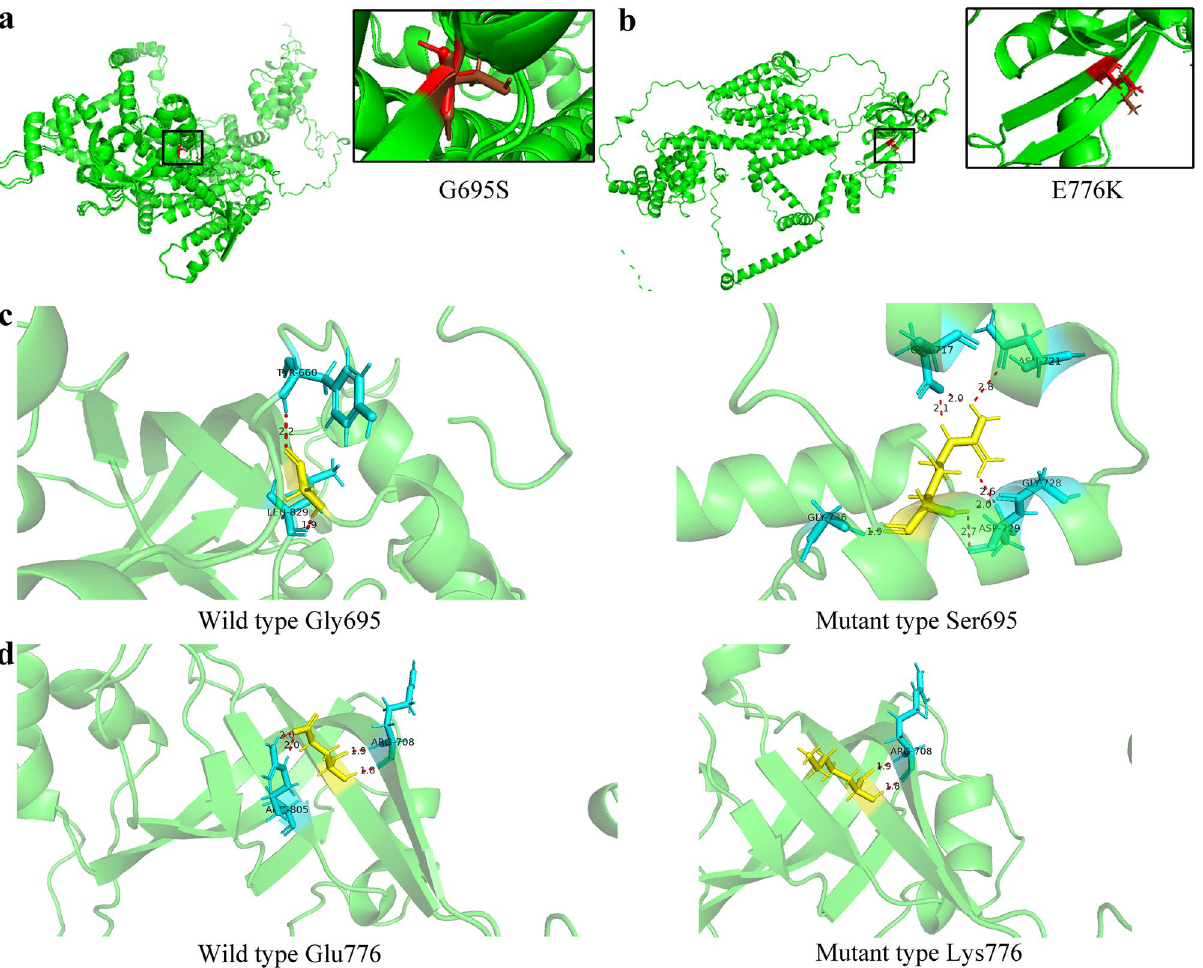
Figure 7. 3D protein modeling of WFS1 variants at amino acid residue 695 and 776. ( a,b ) Predicted structures depict the changes of mutant wolframin protein with the amino acid change G695S, and E776K. Red and brown structures indicate differences between wild and mutant type. ( c,d ) The change of hydrogen bond between amino acids before and after mutation. The proteins are shown as cartoon. Amino acids at the mutated site are highlighted in yellow and the interacting amino acids are highlighted in blue (red dotted line: the hydrogen